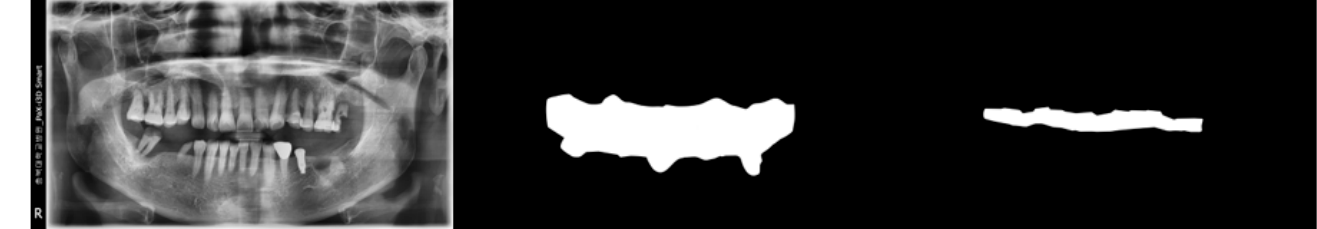
Figure 1. Original dataset, PBL mask, and CEJ mask.